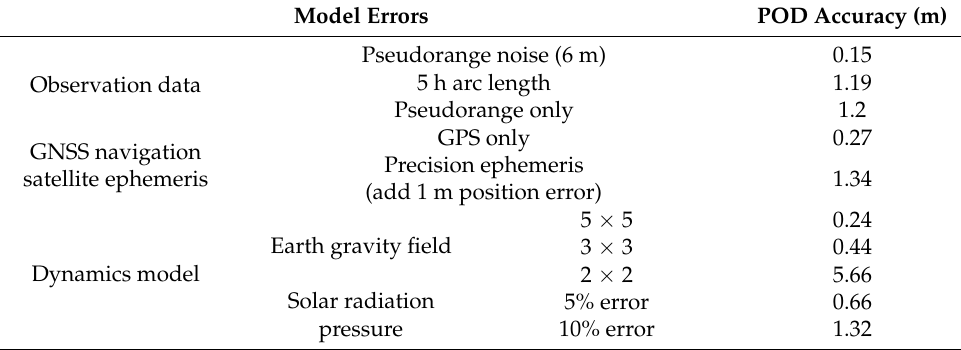
Table 5. POD accuracy with different model errors (RMS).